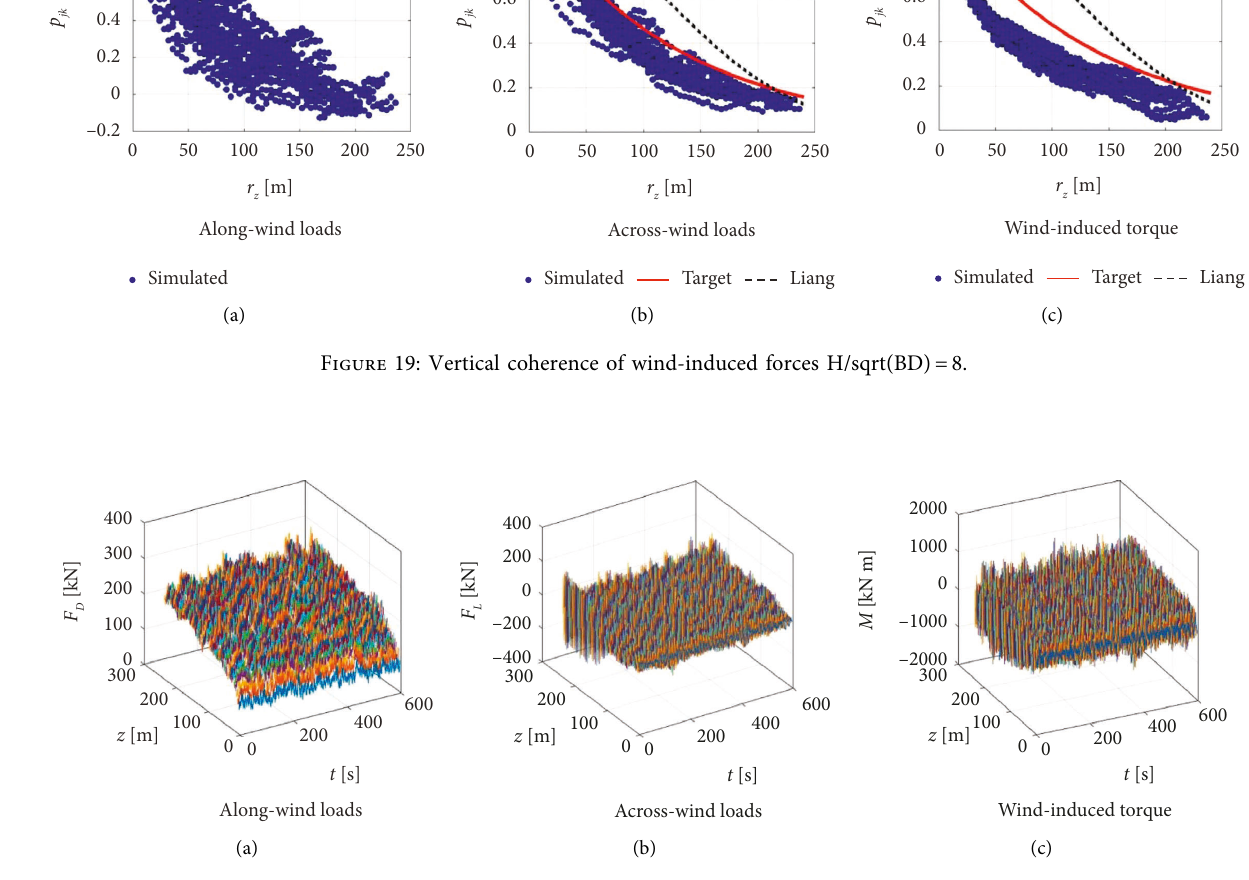
Figure 20: Simulation of wind-induced loads in time domain H/sqrt(BD) �